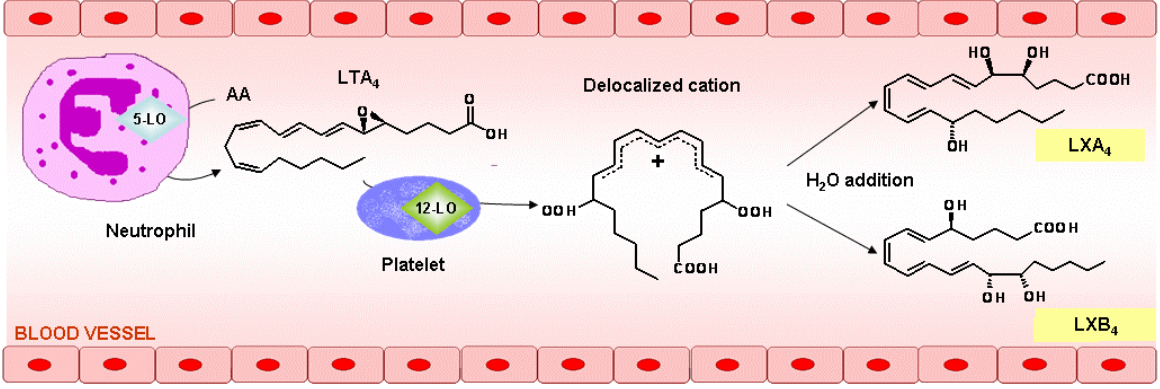
FIGURE 1. The 5-/12-LO biosynthetic pathway of LXs (see text for details).